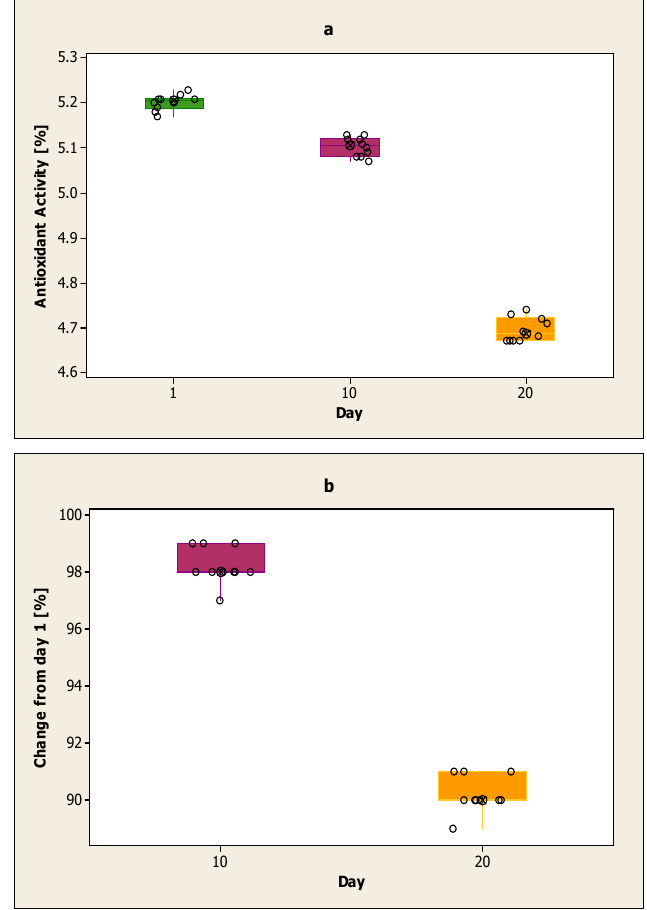
Figure 5. ( a ) Antioxidant activity of the yoghurt sample from cow milk with the addition of volatile lavender oil encapsulated in sodium alginates on the first day, the 10th day and the 20th day; ( b ) Decline on day 10 and day 20 for the yoghurt sample from cow milk with the addition of volatile lavender oil encapsulated in sodium alginates compared to day